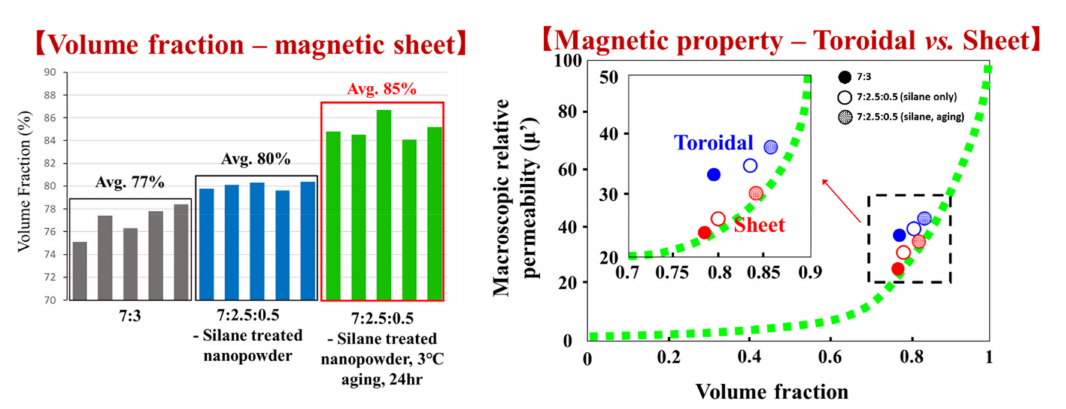
Figure 10. Evaluation of the volume fraction and permeability of the magnetic sheet manufactured under each